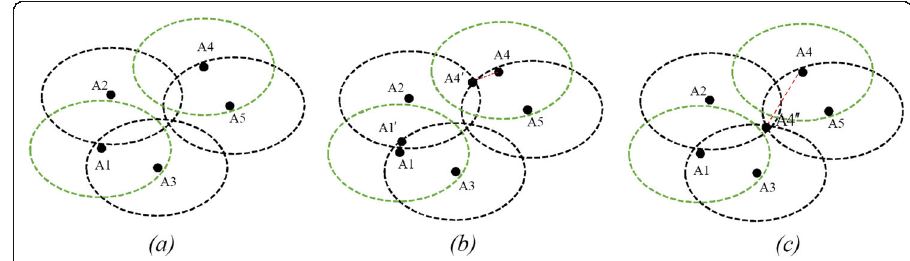
Fig. 3 Selection of pathway and sponsor nodes for three partitions, ( a ) partitioned network, ( b ) two moved sponsor node, ( c ) single moved sponsor